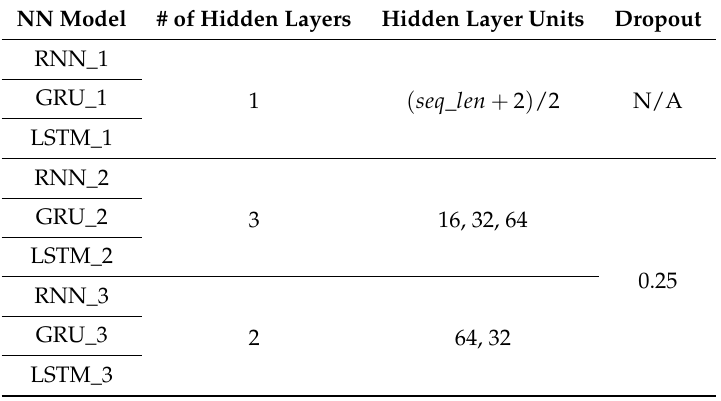
Table 1. Configurations of NN